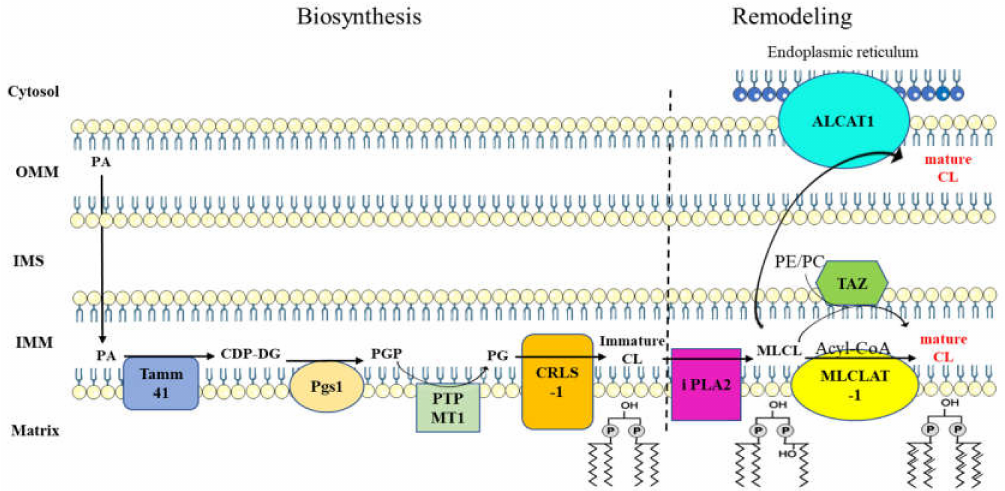
Figure 2. Cardiolipin metabolism is a two-step process. Biosynthesis step results in the formation of immature CL with acyl chain composition that is not yet definitive. Fatty acyl chain of immature CL undergoes several modifications through the activity of remodeling proteins, leading to the